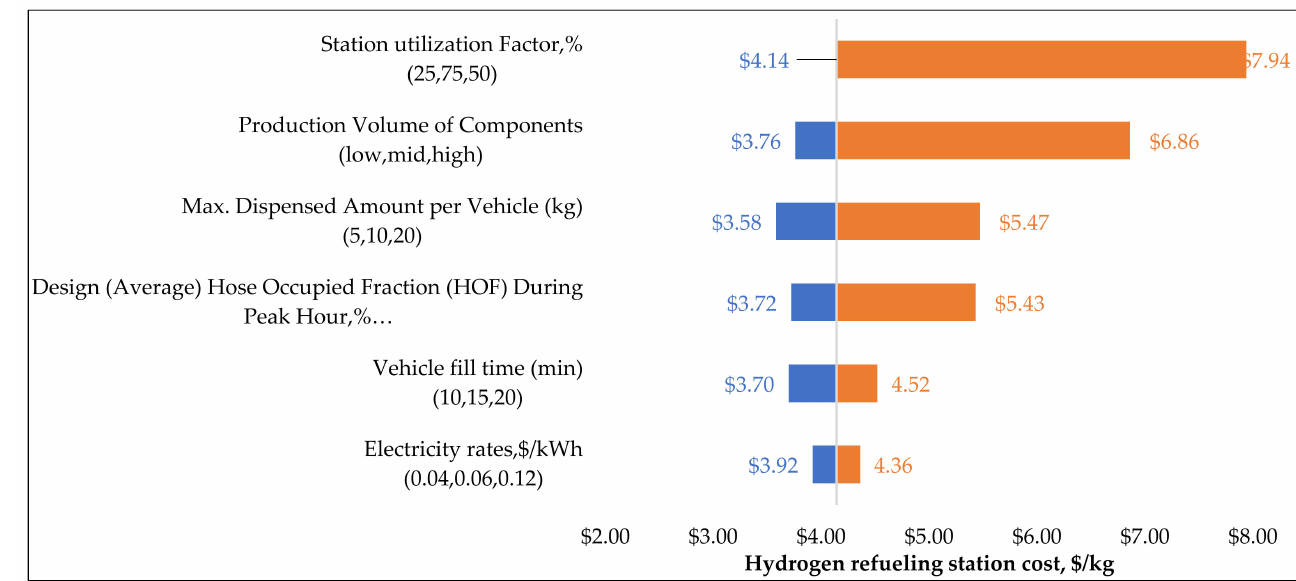
Figure 15. Range of refueling costs for a station receiving hydrogen through pipelines.